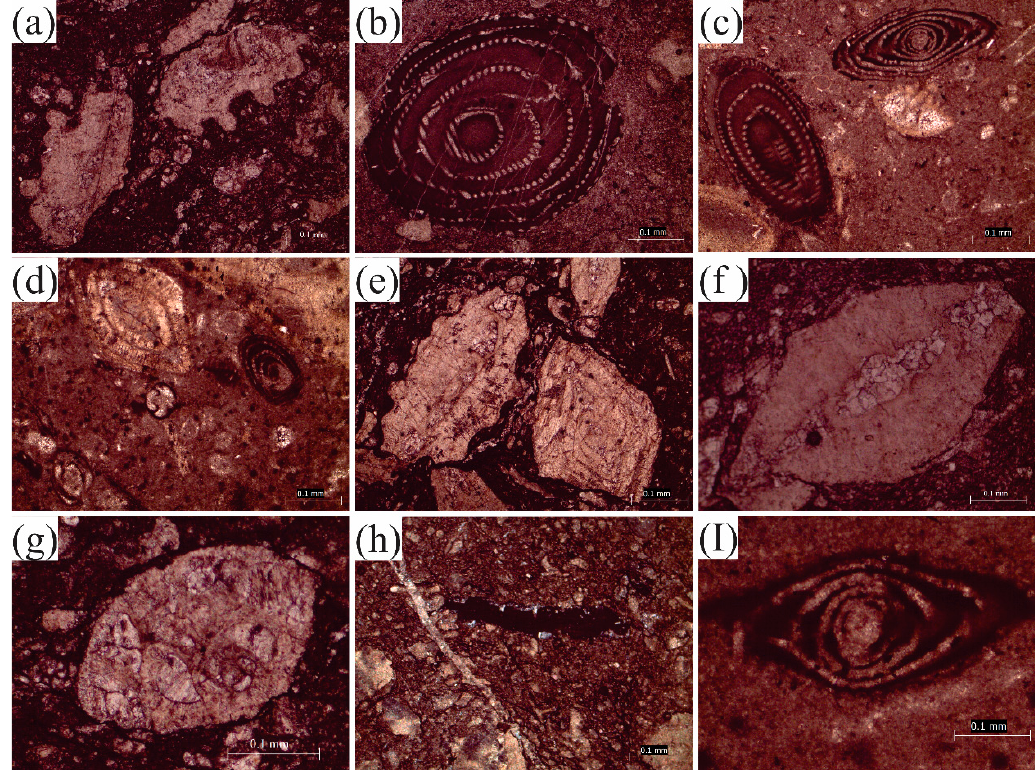
Figure 12. Photomicrographs showing ( a ) micritized bioclasts; ( b , c ) Alveolina spp., ( d ) Nummulites on the left and Alveolina spp. on the right; ( e ) Assilina spp. on the left and Nummulites spp. on the right; ( f ) micritized Assilina spp.; ( g ) Rotalia trochodiformis ; ( h ) carbonaceous material and chert replacing bioclast; and ( I ) Nummulites is replaced by carbonaceous material.